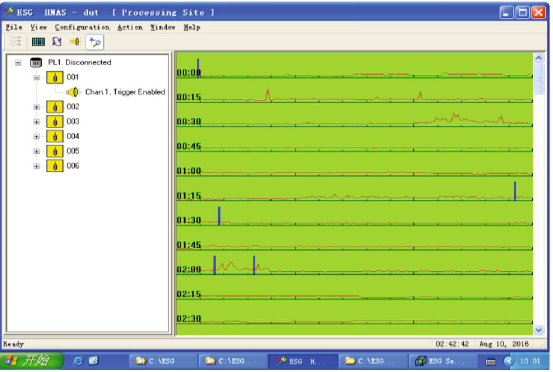
Figure 27: HNAS interface fi